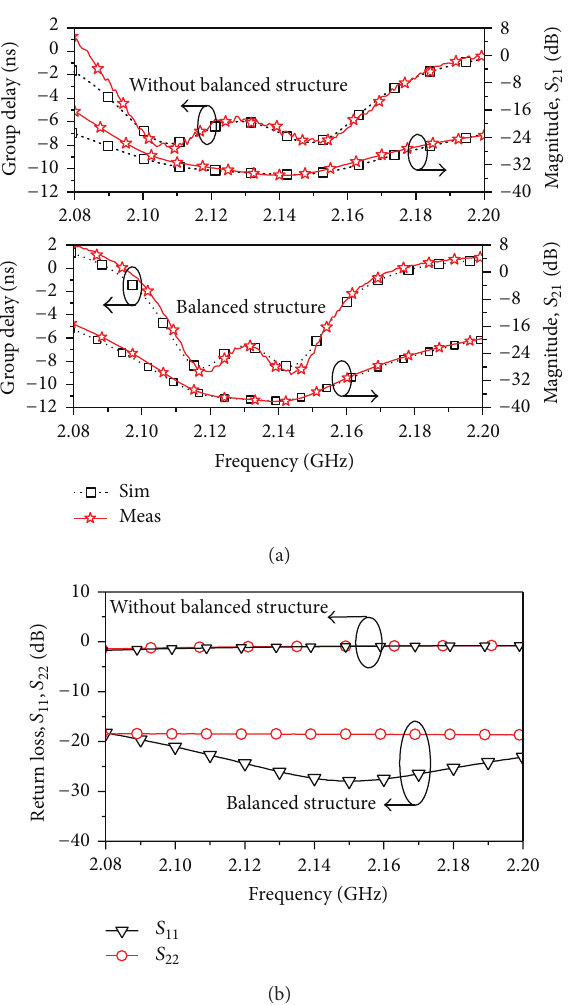
Figure 5: Two-stage DMS-NGD networks: (a) simulated and mea- sured group delay and magnitude characteristics and (b) measured return loss characteristics.